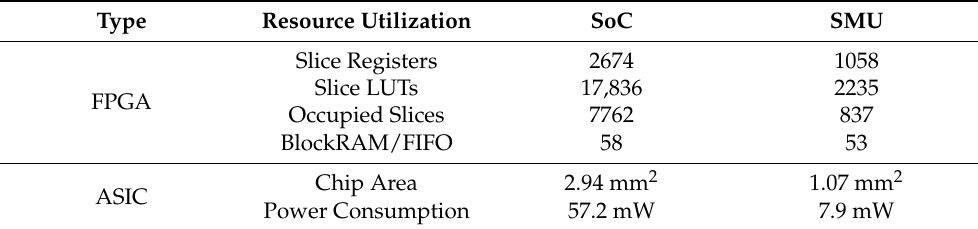
Table 5. The SoC hardware overhead on FPGA and ASIC